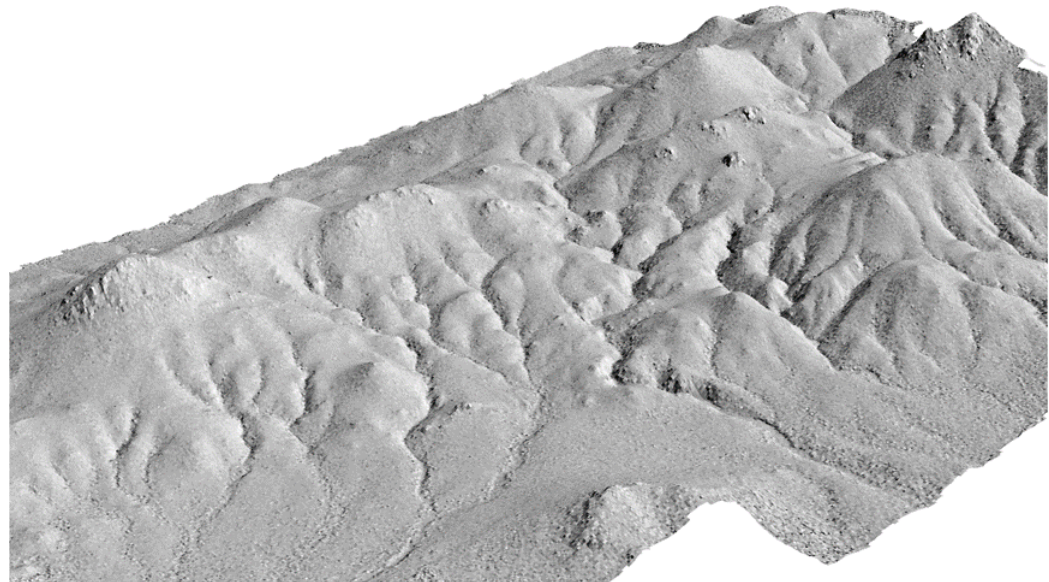
Fig. 6. Created hill shade raster from the